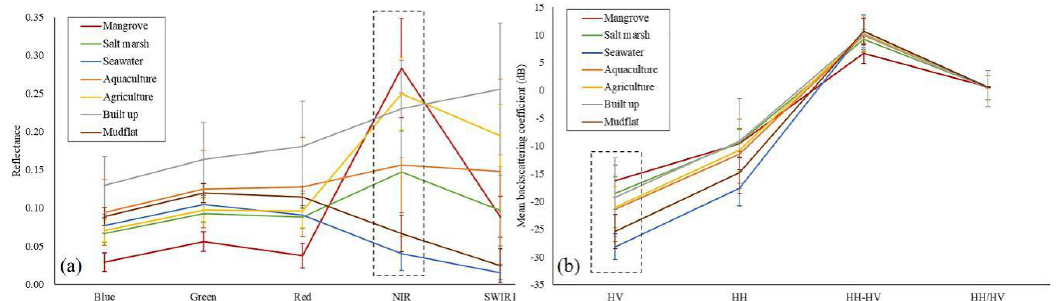
Figure 4. Separability of different land covers in terms of: ( a ) Spectral reflectance from Landsat 8 Surface Reflectance (SR); ( b ) Backscattering coefficient from PALSAR-2.